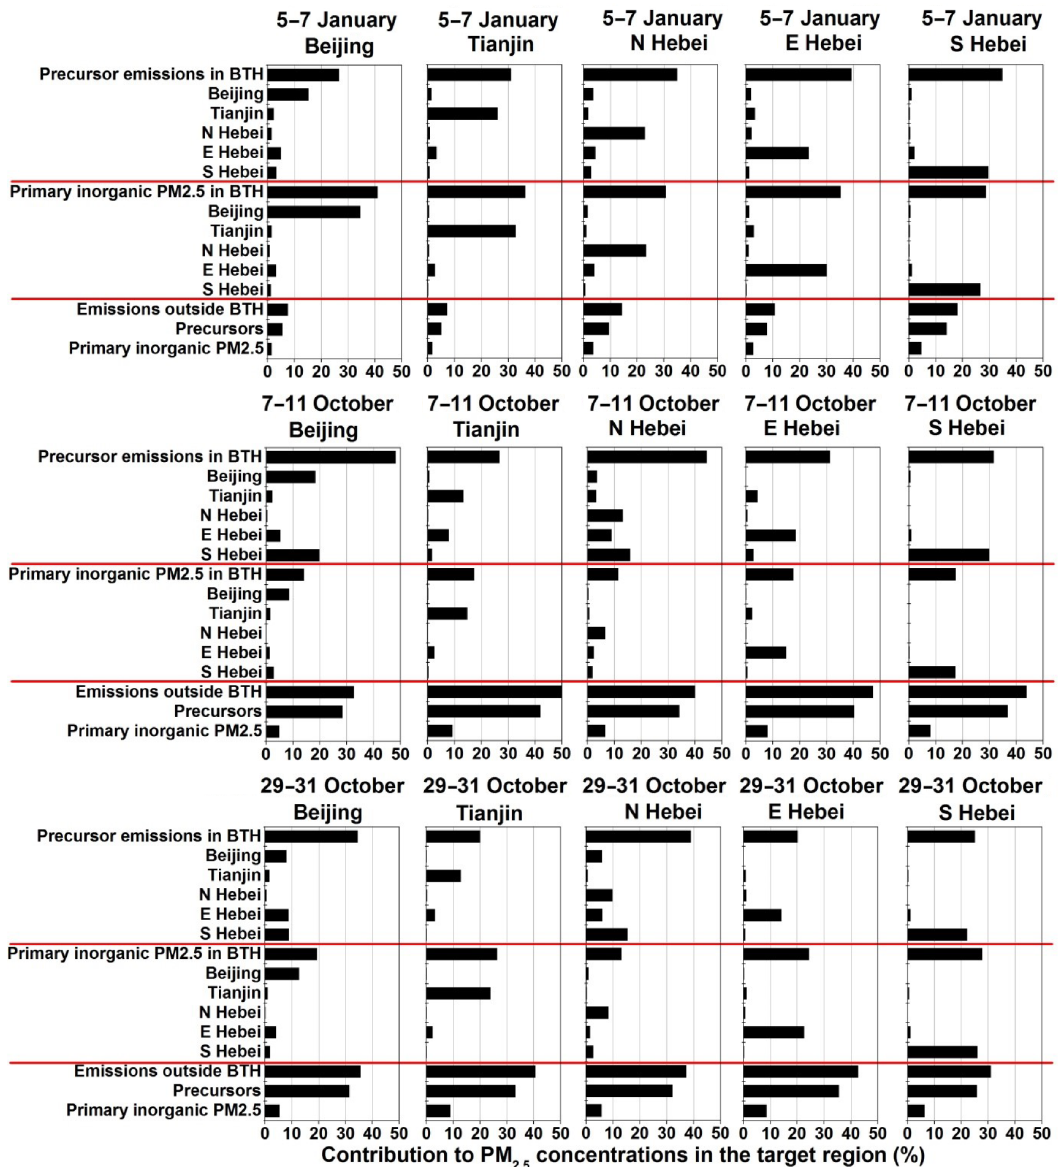
Figure 8. The contribution of precursor (NO x , SO 2 , NH 3 , NMVOC, IVOC, and POA) and primary inorganic PM 2 . 5 emissions from indi- vidual regions to PM 2 . 5 concentrations during three typical heavy-pollution